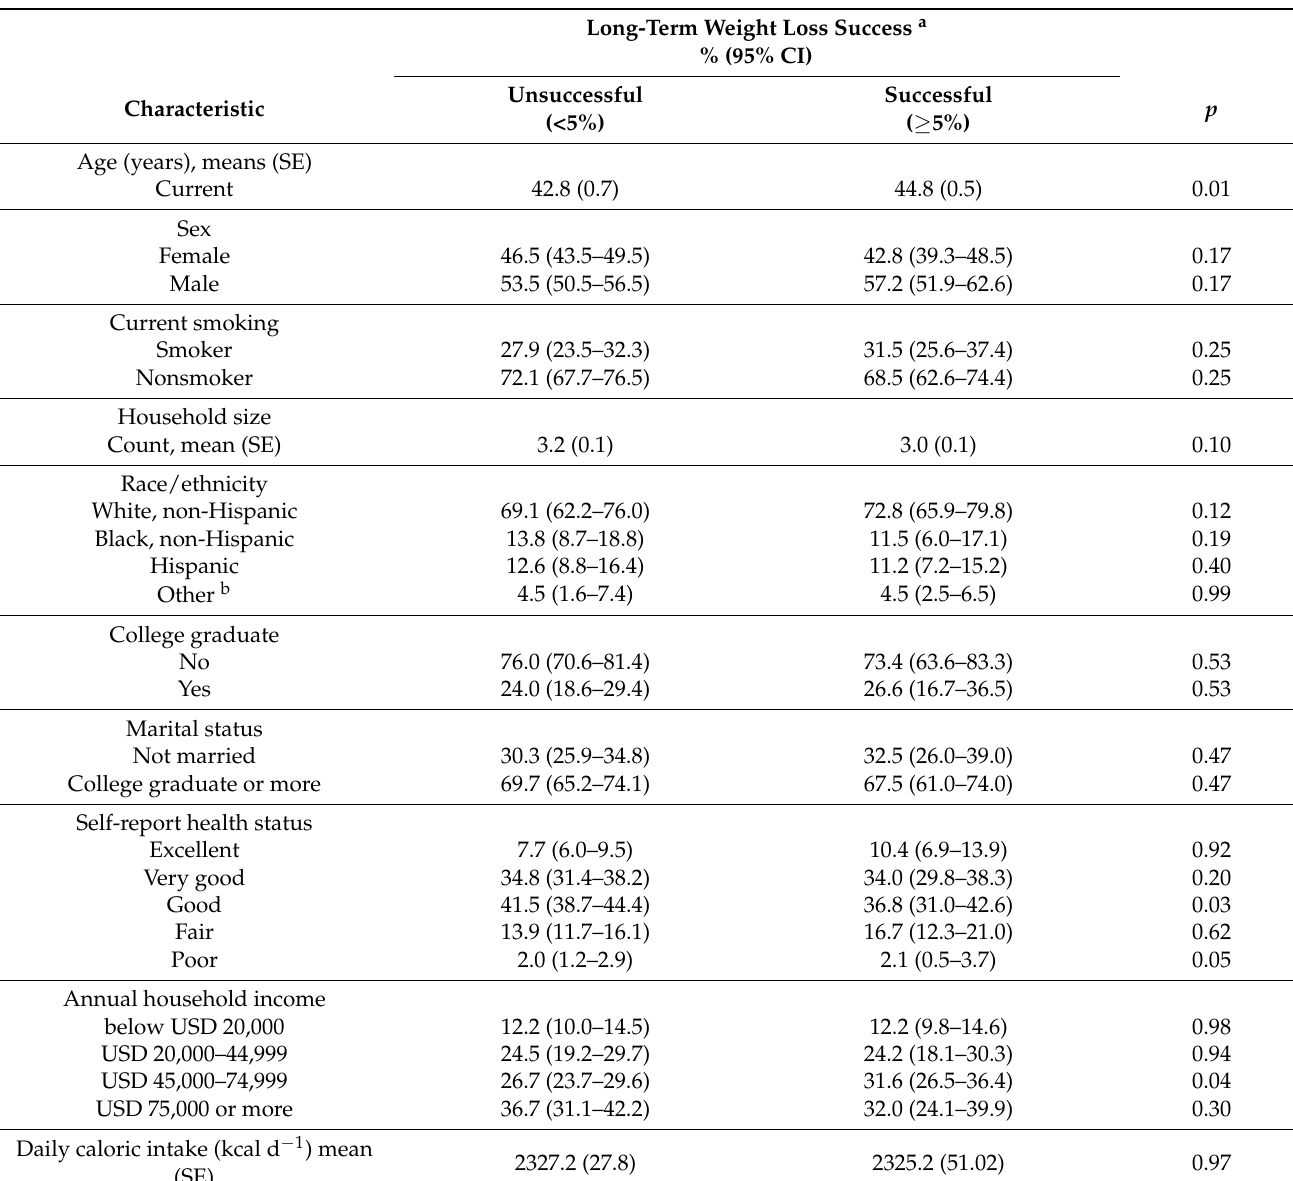
Table 1. Participants’ characteristics by long-term weight loss